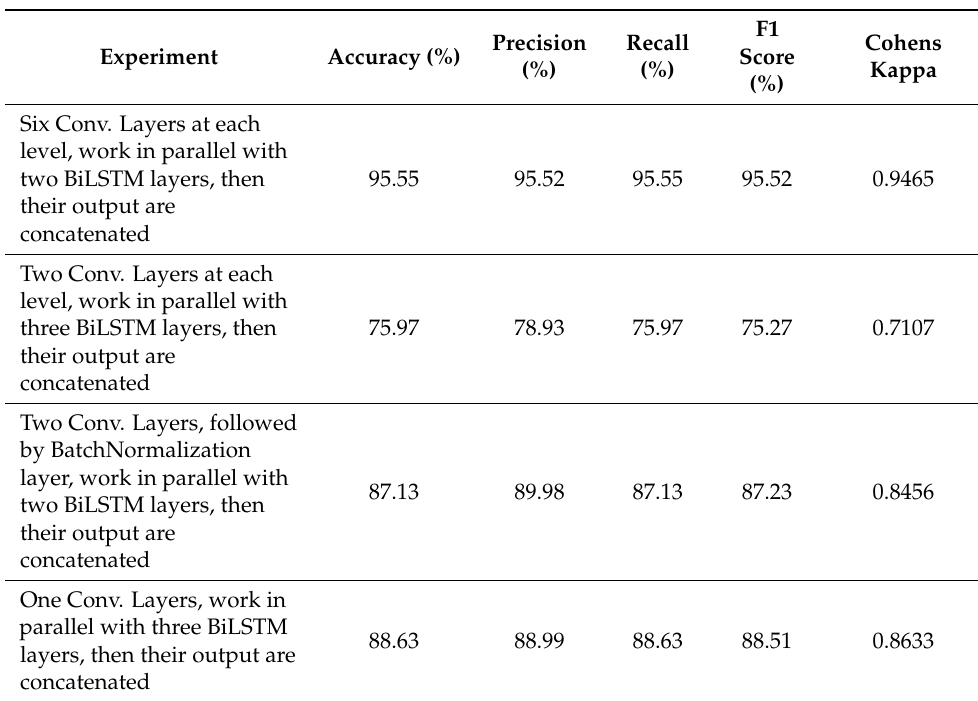
Table 9. Ablation